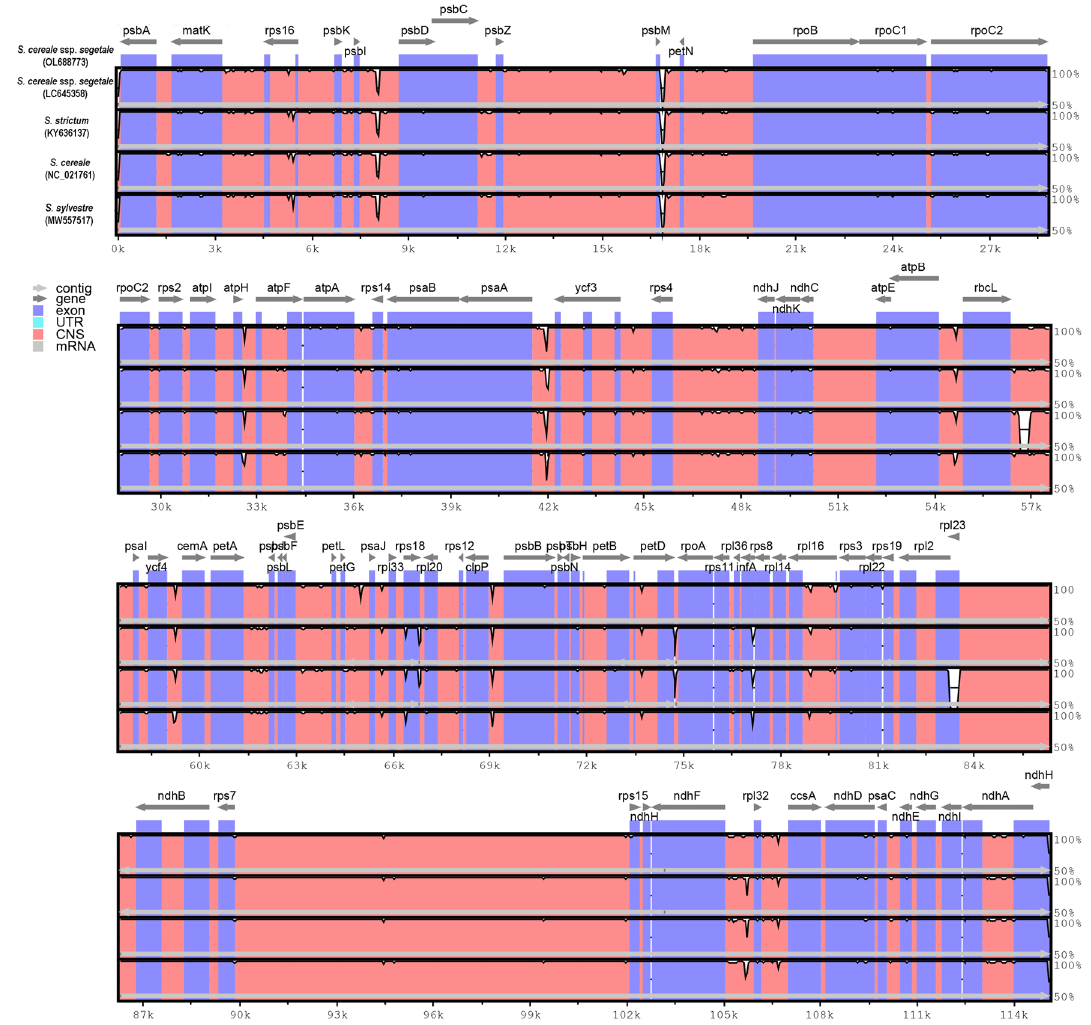
Figure 3. Percentage of sequence identity between chloroplast genomes of Secale cereale ssp. segetale and other four Secale species using mVISTA program. Gray arrows on the top line show transcriptional direction. The y-axis represents average percent identity between sequences of S. cereale ssp . segetale and other three Secale chloroplast genomes. The x-axis represents the coordinate in the chloroplast genome using S. cereale ssp. segetale as reference. Genome regions are color coded as exon, untranslated regions (UTR), and conserved non-coding sequences